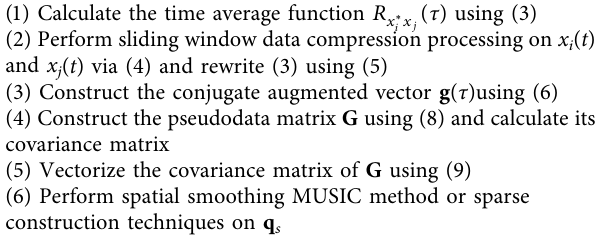
Table 1: Main steps of the proposed method. ( τ ) using (3) (1) Calculate the time average function R x ∗ i x j (2) Perform sliding window data compression processing on x i ( t ) and x j ( t ) via (4) and rewrite (3) using (5) (3) Construct the conjugate augmented vector g ( τ )using (6) (4) Construct the pseudodata matrix G using (8) and calculate its covariance matrix (5) Vectorize the covariance matrix of G using (9) (6) Perform spatial smoothing MUSIC method or sparse construction techniques on q